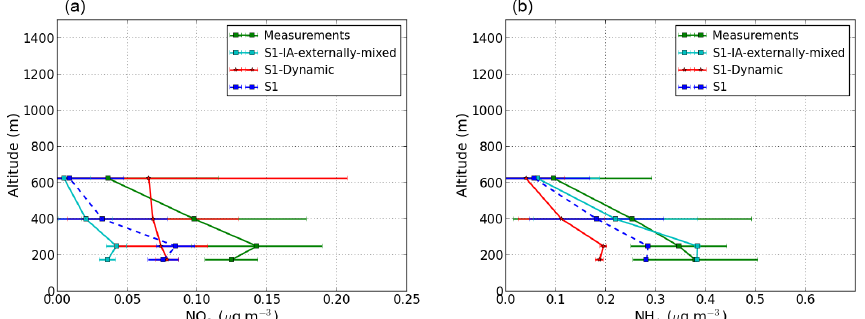
Figure 5. Vertical profile averaged at four model levels of NO 3 (a) and NH 4 (b) . Measurements are averaged at the same four model levels from airborne observations below 800ma.g.l along the flight shown in Fig. 1 on 10 July 2014 (around